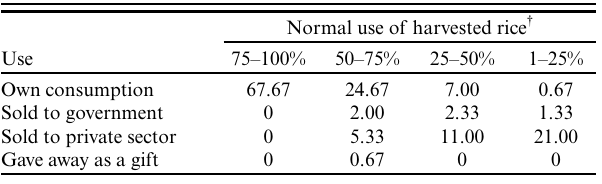
Table 1 . How households use rice harvested from their fields. (Each cell represented as a percentage of all households [N = 300]).